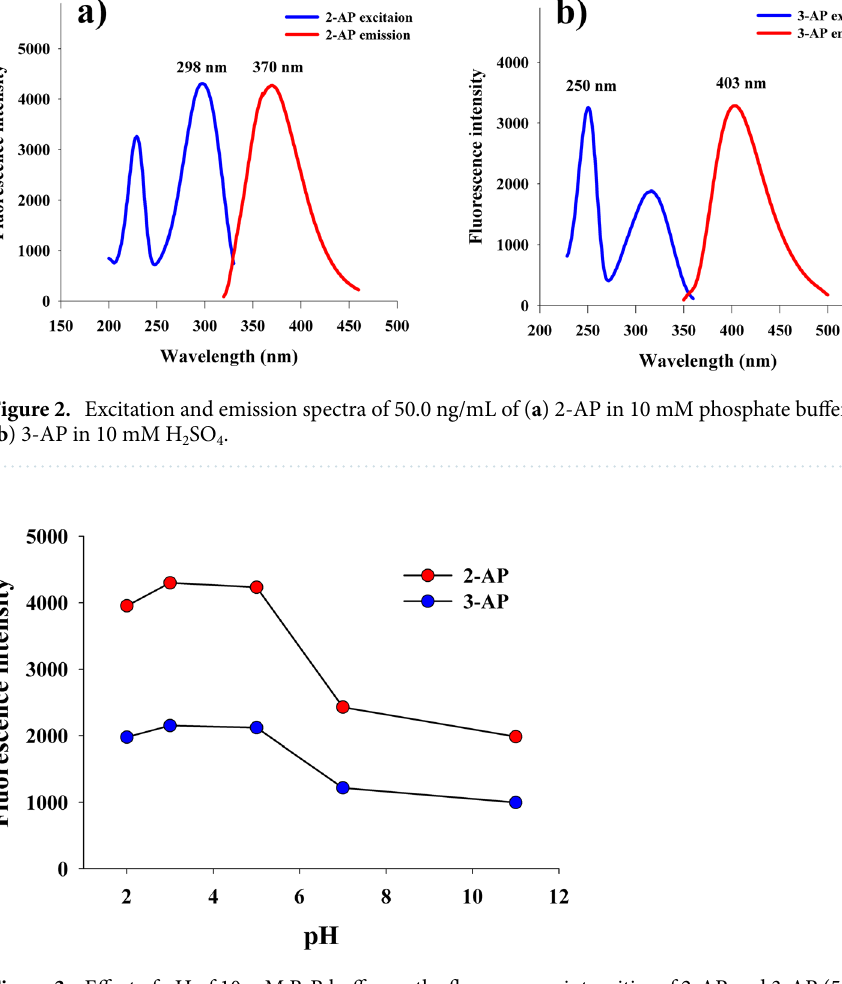
Figure 3. Effect of pH of 10 mM B-R buffer on the fluorescence intensities of 2-AP and 3-AP (50.0 ng/mL).